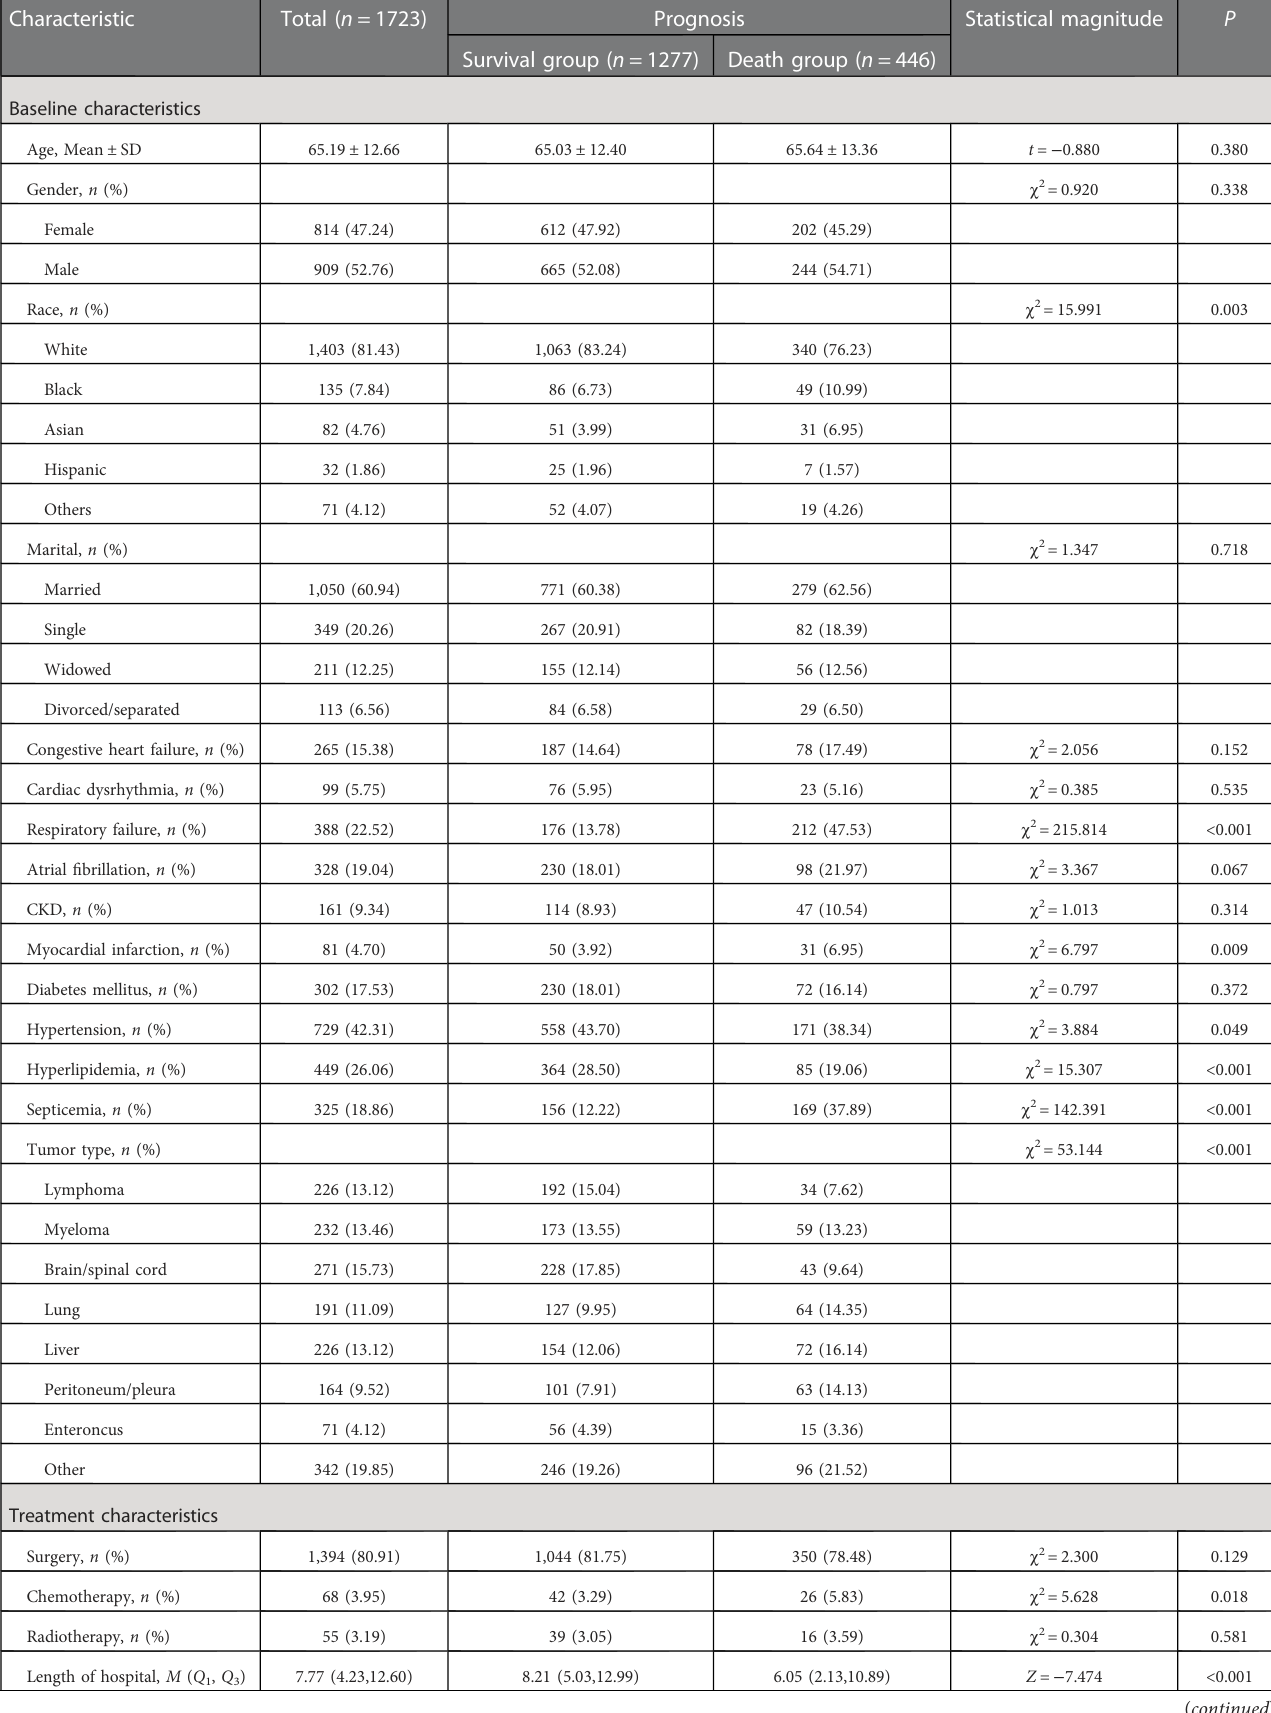
TABLE 2 Comparisons of the characteristics in patients between the survival group and the death group in the training